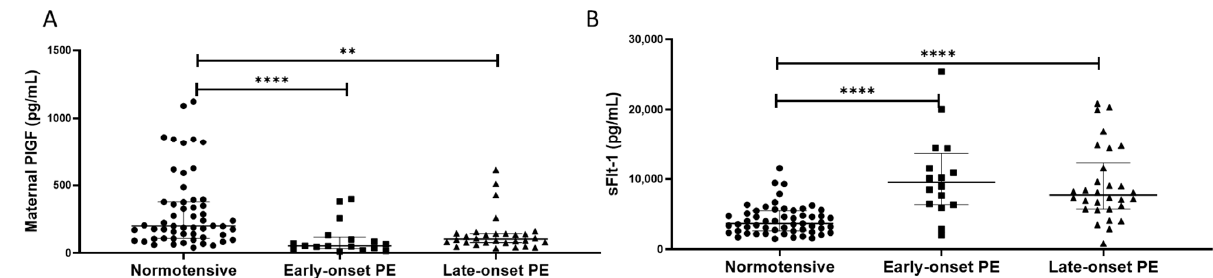
Figure 5. ( A ) Maternal plasma placental growth factor (PlGF) concentrations and ( B ) maternal plasma soluble fms-like tyrosine kinase-1 (sFlt-1) concentrations in normotensive pregnant women (n = 55) and those with early- (n = 17) and late-onset (n = 30) pre-eclampsia (PE). Data presented as median (IQR); ** p < 0.005; **** p < 0.0001. In contrast, plasma sFlt-1 concentrations were higher in women with pre-eclampsia (8300 (6194, 13155) pg/mL), compared to normotensive controls (3844 (2591, 5483); p < 0.0001). When sub-grouped, higher sFlt-1 concentrations were found in both the early- (10090 (6459, 13115)) and late-onset samples (8111 (5724, 11571)), compared to normotensive controls ( p < 0.0001 for both; Figure 5B).